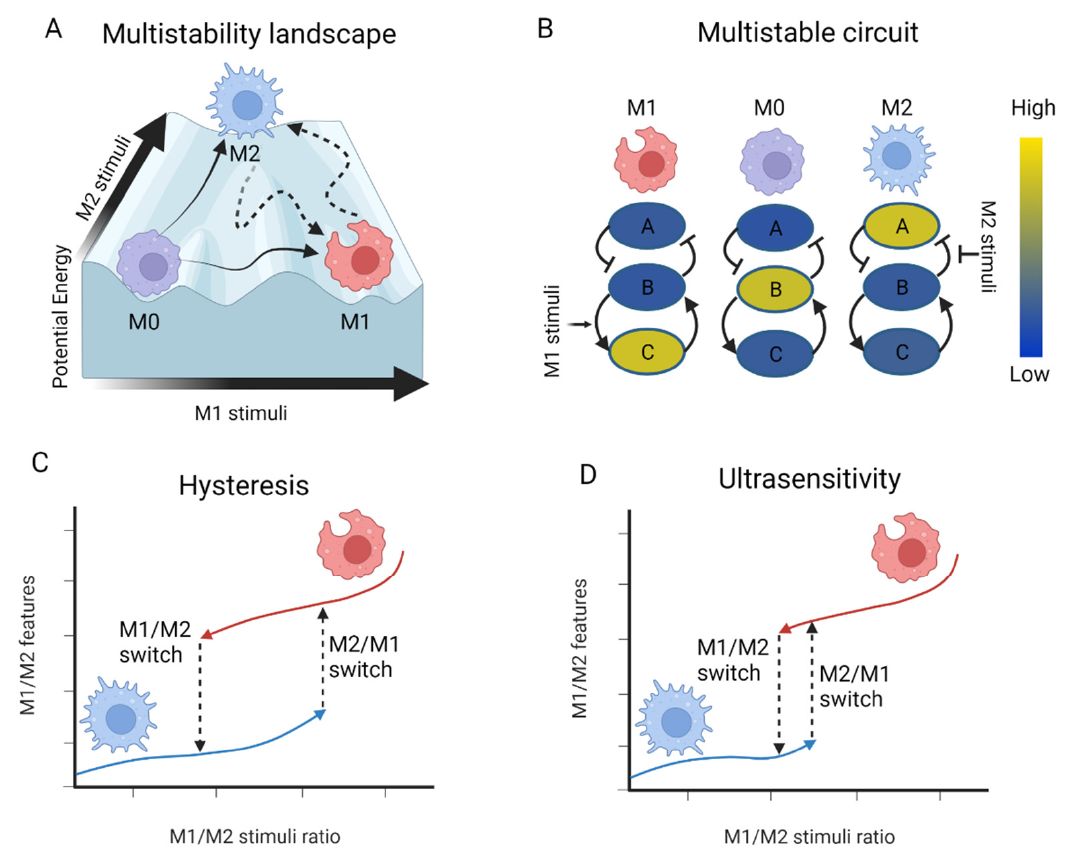
Figure 1. Concept of multistability and hysteresis in macrophage activation: ( A ) Concept of